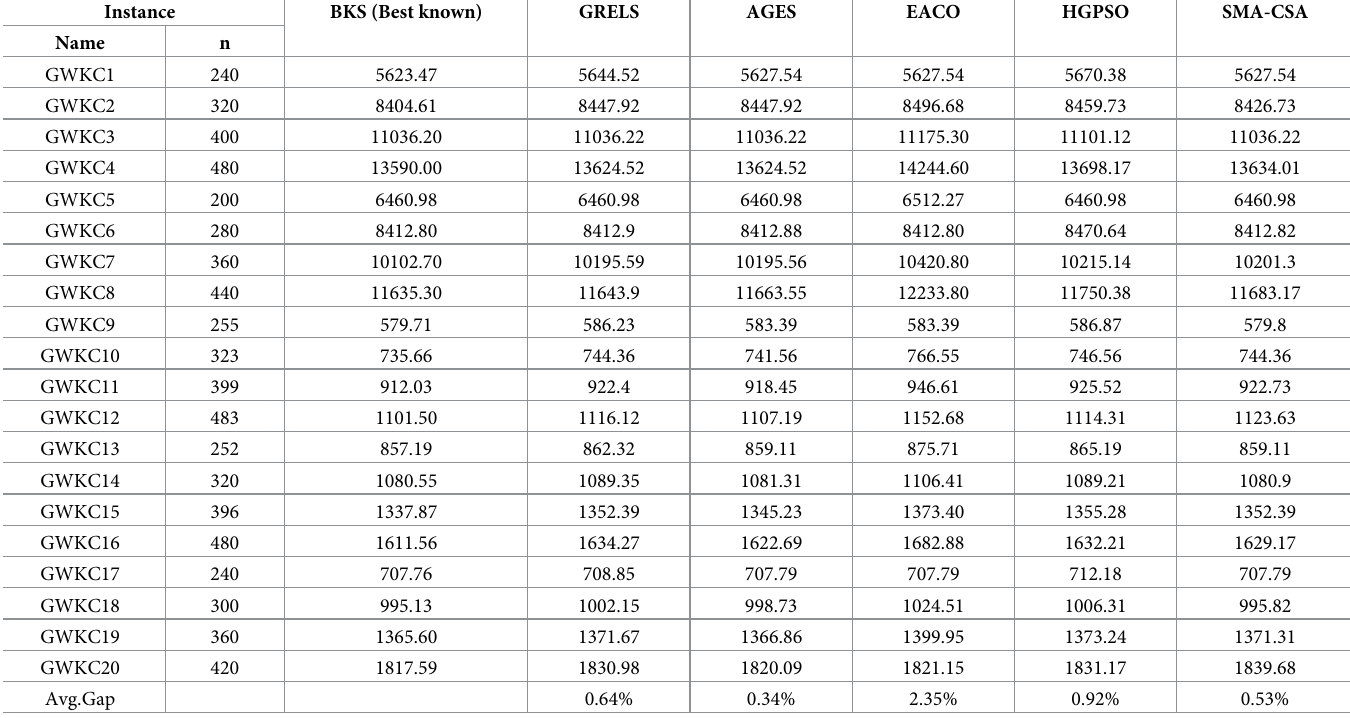
Table 14. Comparison results on Golden’s benchmark datasets of CVRP with advanced algorithms.